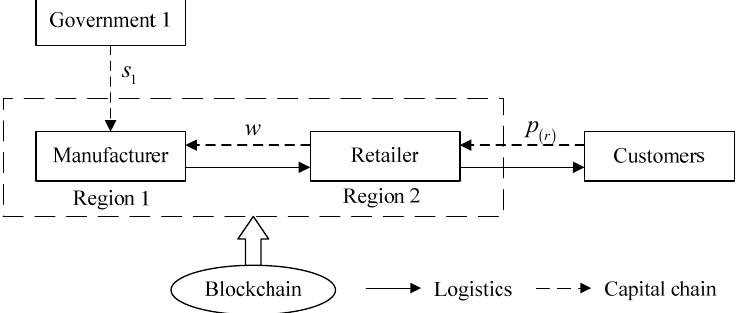
Figure 2. The structure and interaction process of FPSC system in Strategy SN.